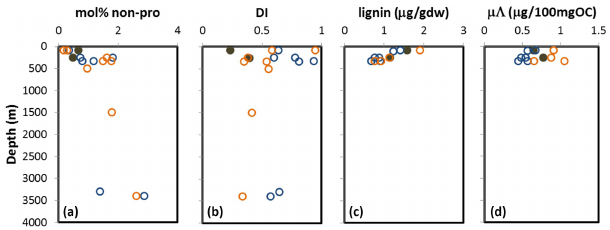
Figure 5. (a) Mole percentage of non-protein amino acids, (b) amino acid degradation index, (c) lignin phenol yield per gram dry weight of sinking material, and (d) µ (cid:51) , the lignin yield in mi- crograms per 100mg organic carbon. (Color scheme for symbols same as in Fig.